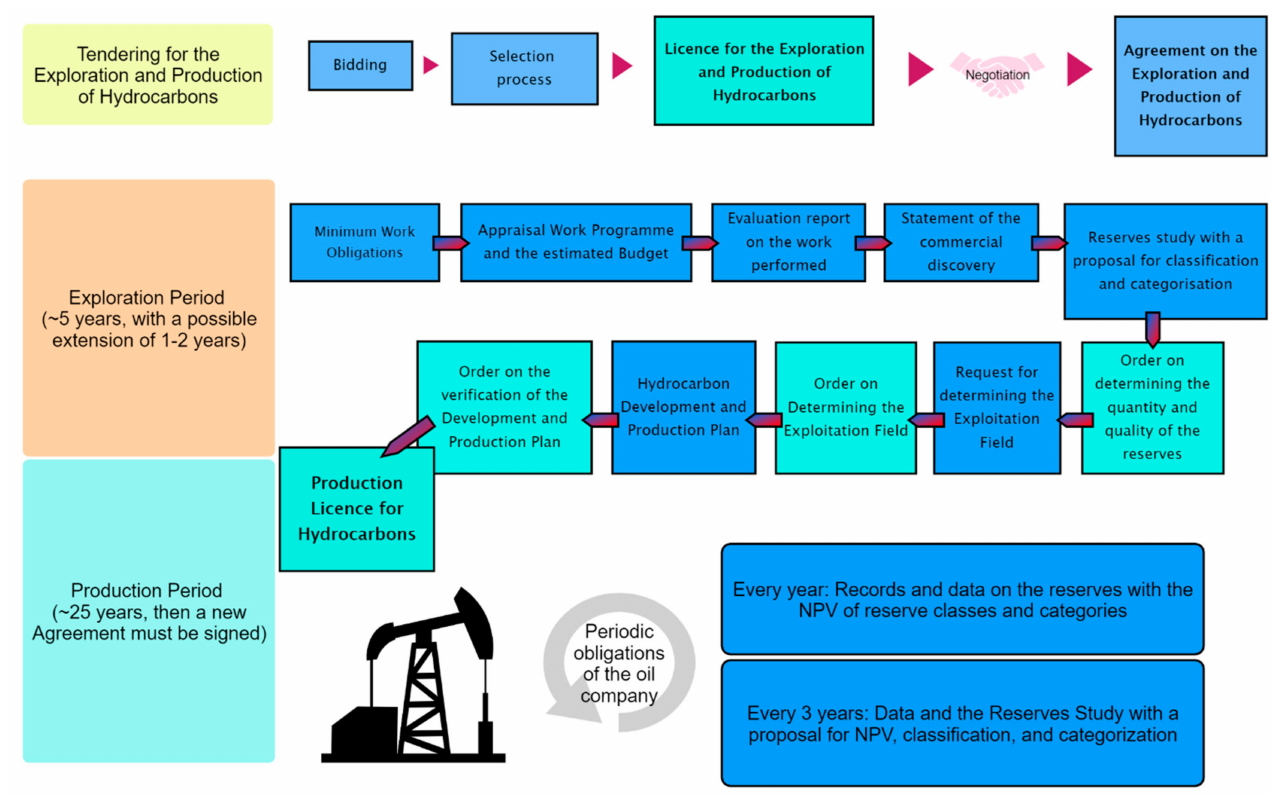
Figure 1. Process of obtaining a concession for exploration and production of hydrocarbons in the Republic of